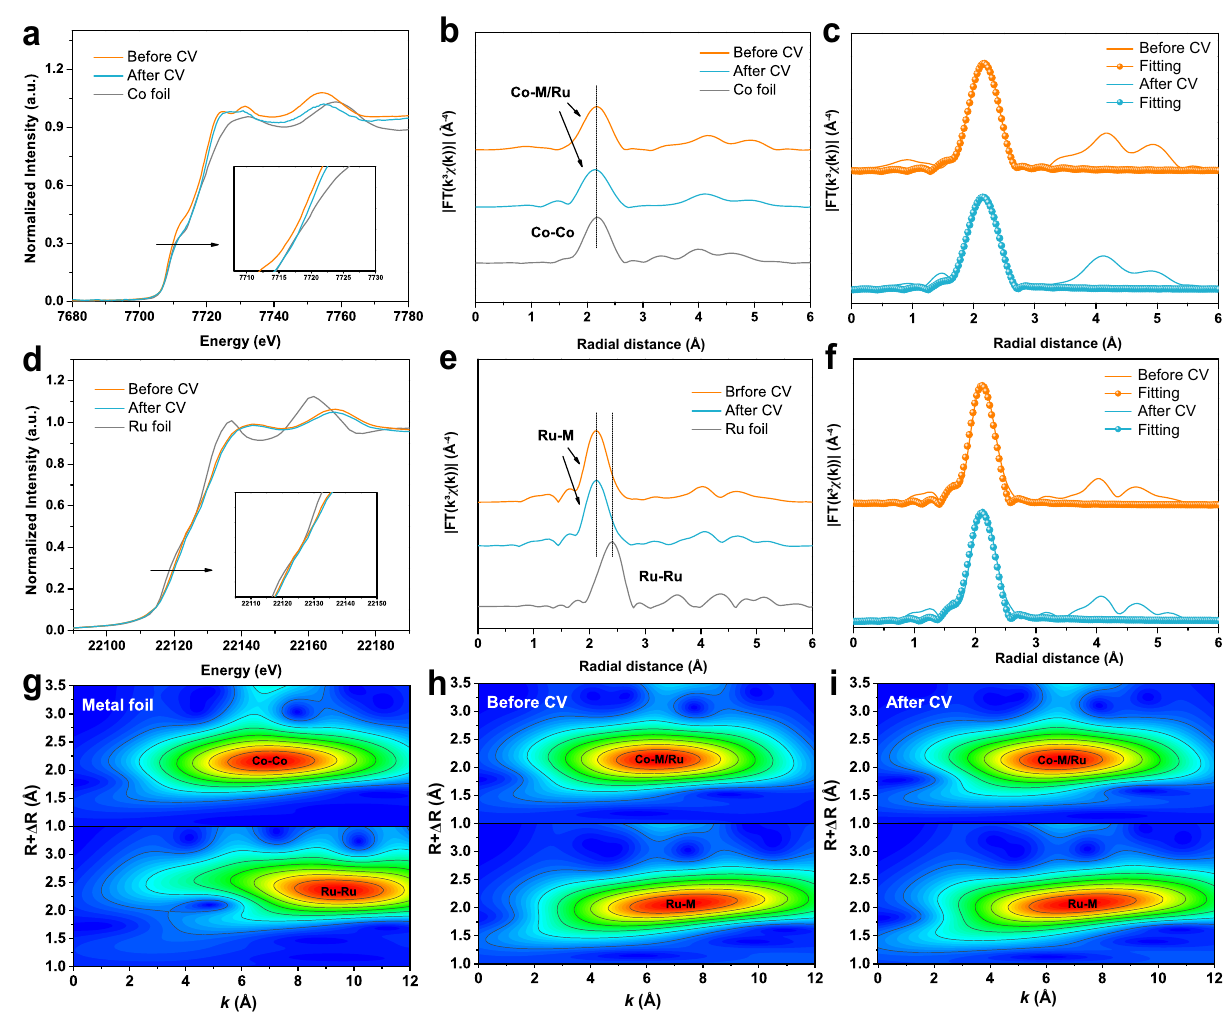
Fig. 5 Stability characterization by XAS. a The Co K-edge XANES spectra and b FT-EXAFS spectra of FeCoNiMnRu/CNFs before and after stability test, and Co foil. c The corresponding FT-EXAFS fi tting curves of FeCoNiMnRu/CNFs before and after stability test. d The Ru K-edge XANES spectra and e FT-EXAFS spectra of FeCoNiMnRu/CNFs before and after stability test, and Ru foil. f The corresponding FT-EXAFS fi tting curves of FeCoNiMnRu/CNFs before and after stability test. The WT-EXAFS spectra of Co and Ru in ( g ) metal foils and h , i FeCoNiMnRu/CNFs before and after stability